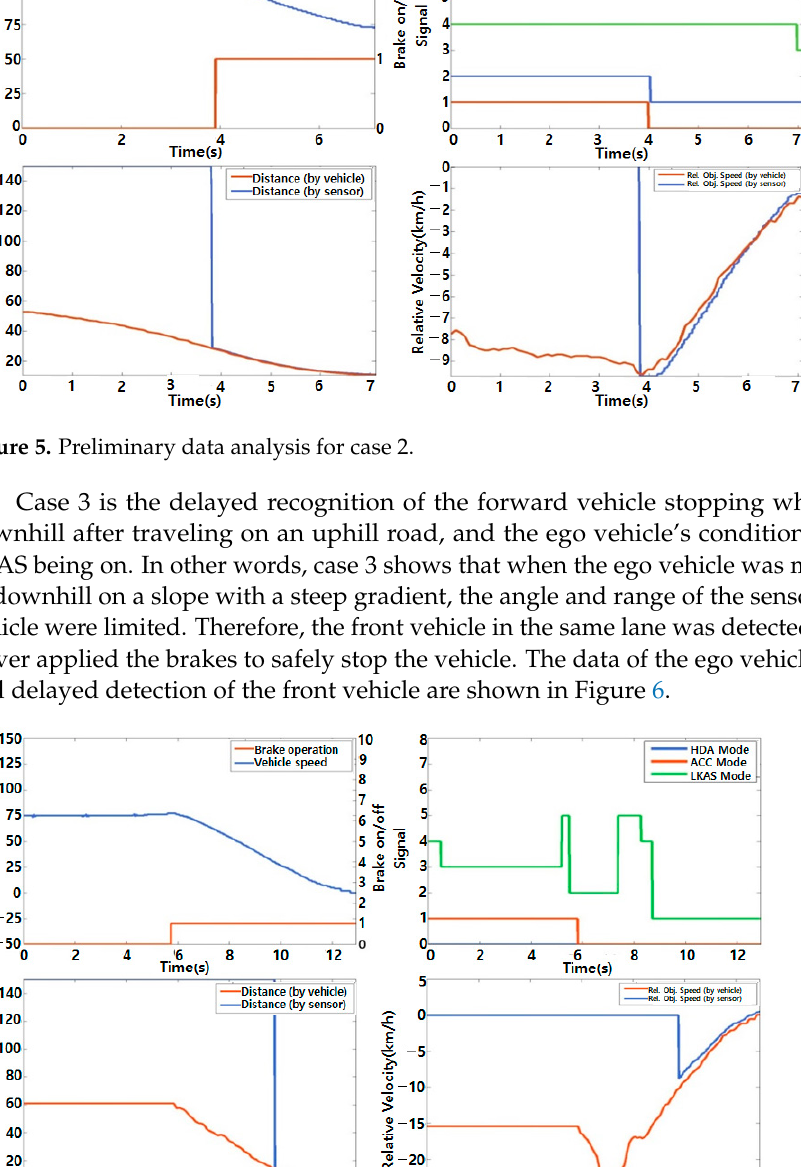
Figure 7. Preliminary data analysis for case 4.